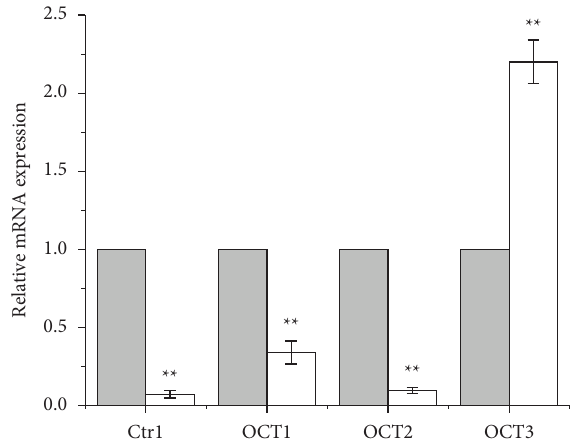
Figure 8: AR of cisplatin and 1 – 3 in A2780 (wild type; gray bars) and A2780cisR (cisplatin-resistant; white bars) cells after 4 h CTat a 10 μ M concentration of compounds. Data are the mean ± SD of three independent replicates and were compared using one-way analysis of variance (ANOVA) with the Tukey post-hoc test.